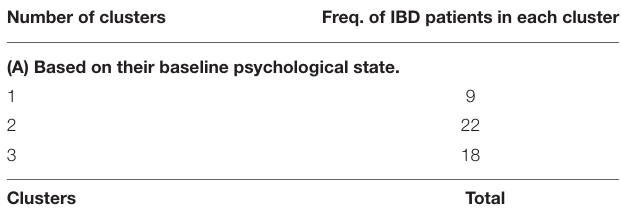
(B) Based on gender, IBD disease phenotype and treatment modalities for